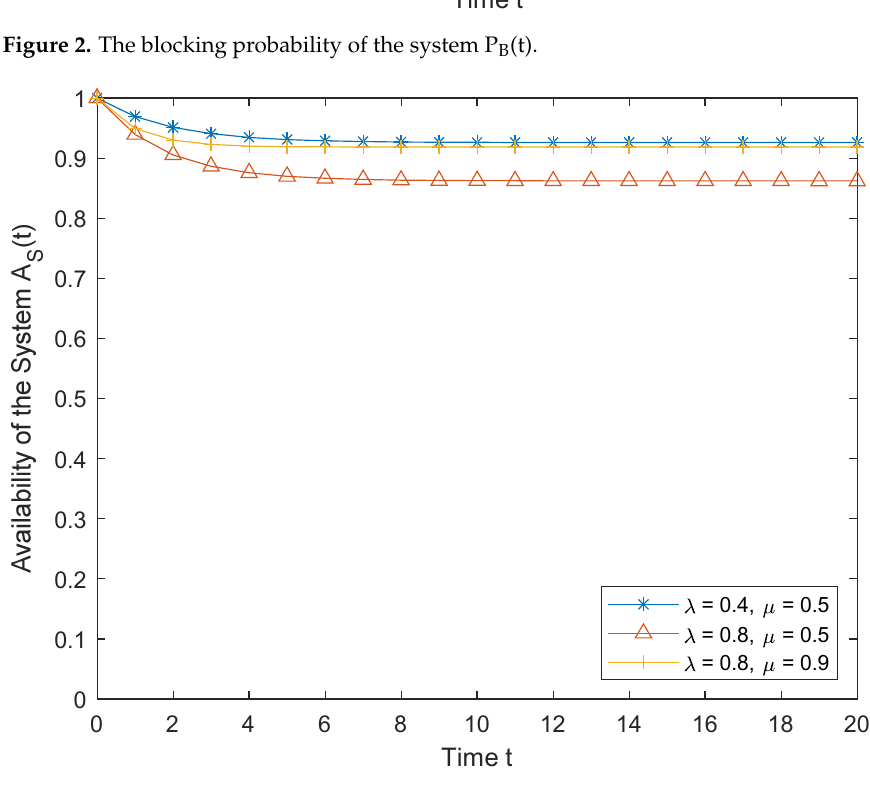
Figure 3. The system availability A S ( t ).